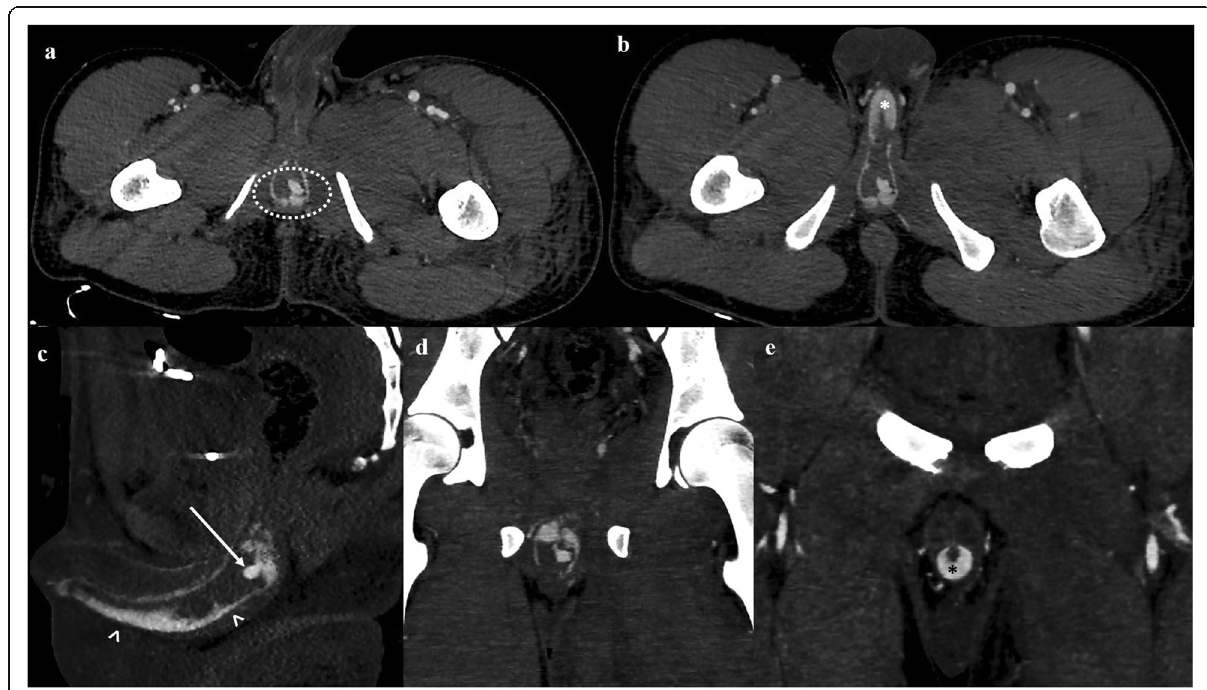
Fig. 2 MDTC, MIP reconstructions in the arterial phase ( a ) axial plane showing pseudoaneurysm at penis root (discontinued white oval); ( b ) axial scan showing early opacification of the penile body (white asterisk); ( c ) sagittal plane with vascular injury at penis root (white arrow) and contrast agent extravasation at third medium-distal of its inferior portion (head of white arrow); ( d ) coronal plane of the bulbar region showing clearly the pseudoaneurysm; ( e ) coronal plane showing early and intense opacification of urethral corpus spongiosum at the third medium portion of the penis (black asterisk)